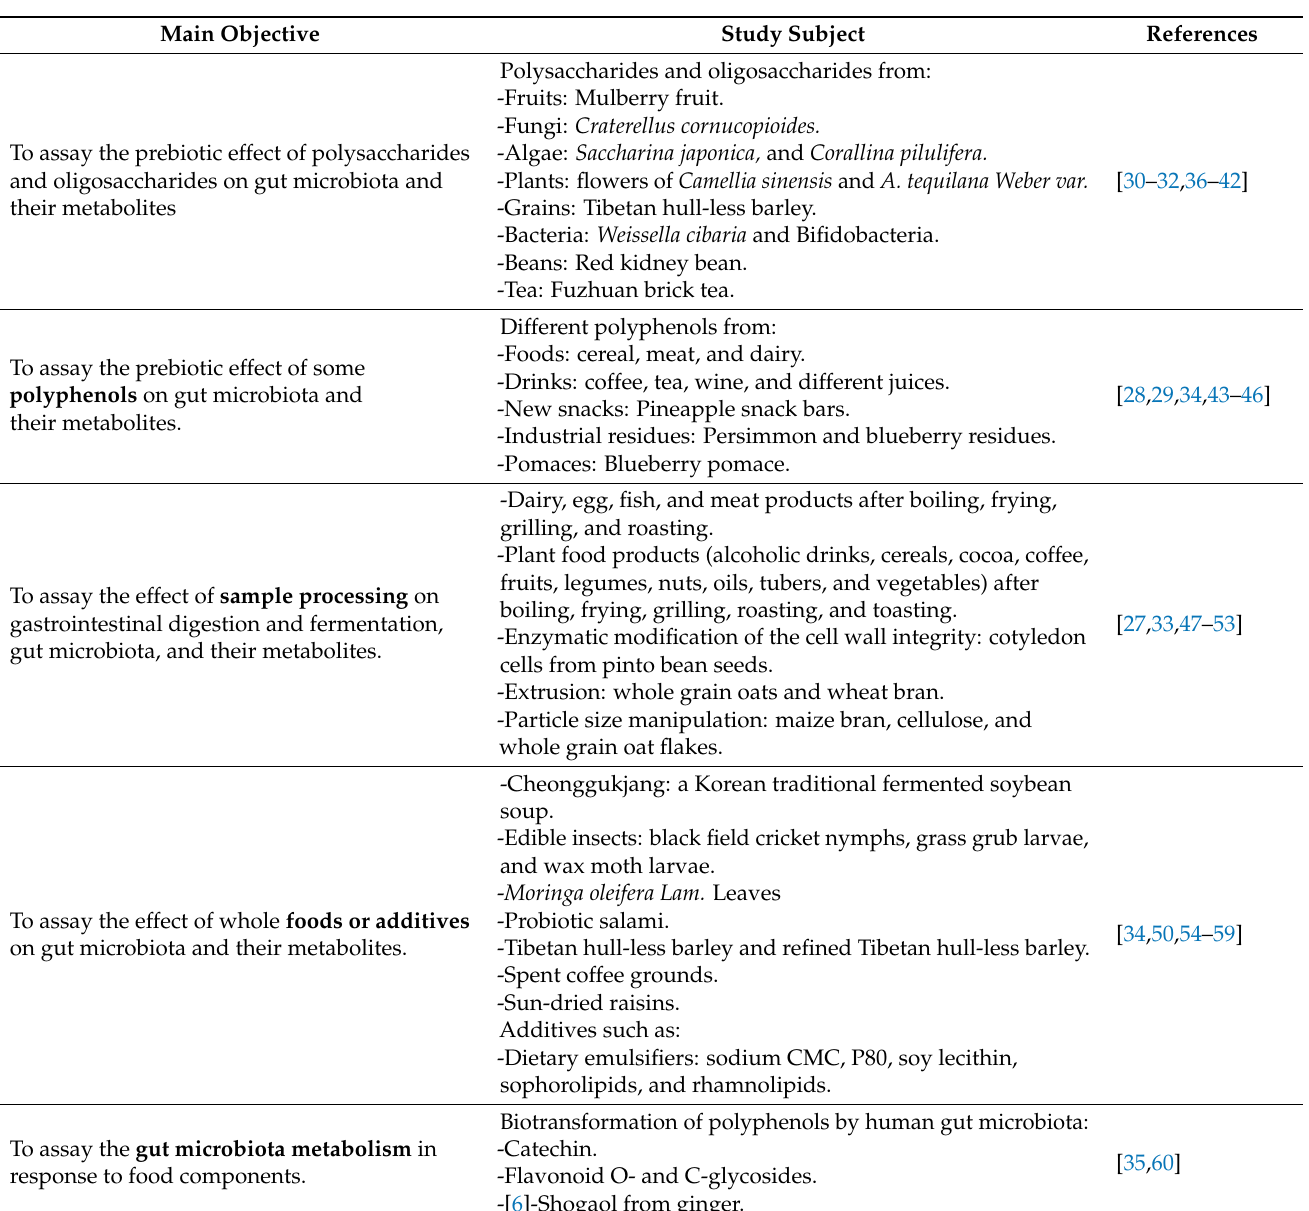
Table 1. Applicability of static in vitro colonic models in the food science and technology field from 2011 to 2021. Main